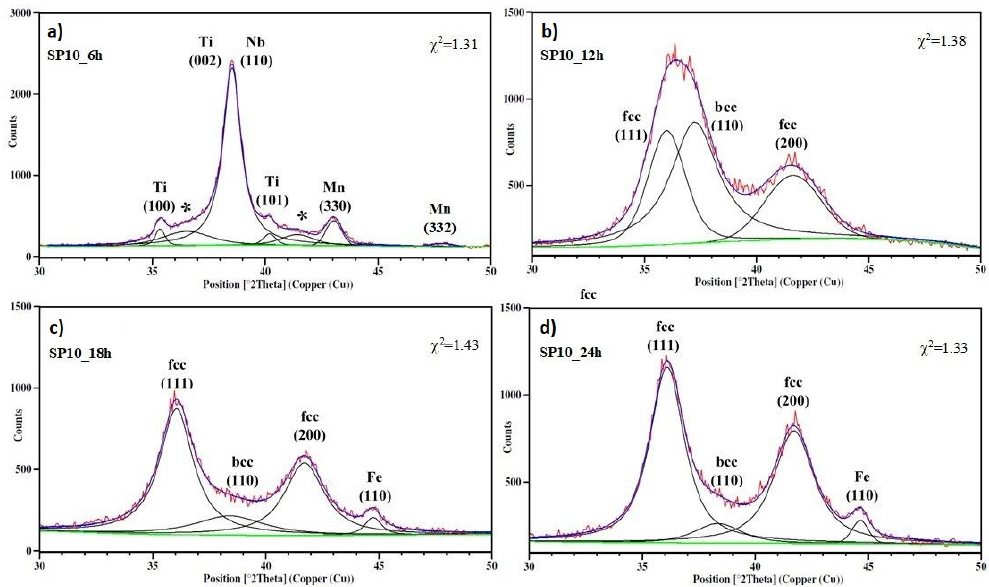
Figure 3. Deconvoluted XRD patterns in the 30°–50° 2 θ range, for the SP10 specimens milled at 6 h ( a ), 12 h ( b ), 18 h ( c ), and 24 h ( d ). The reflections for elemental Ti, Nb, Mn, Fe (this last from contamination), the bcc-, and the fcc-TiNbMn alloys. In brackets are marked the (hkl) Miller index for the corresponding reflections; * unindexed slight peak.